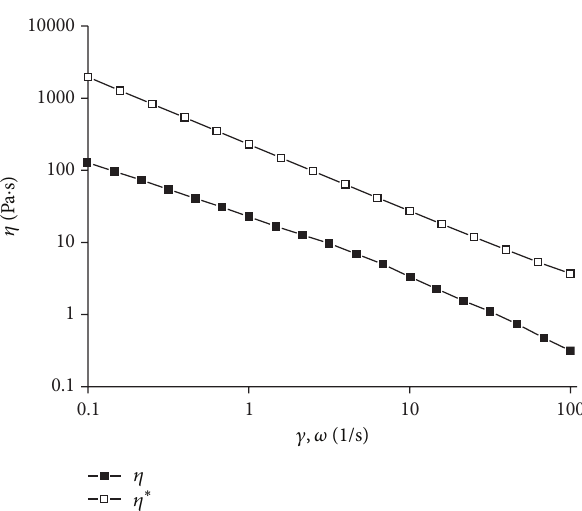
Figure 2: Steady shear flow curves of LP with different concentra- tion of Na + .